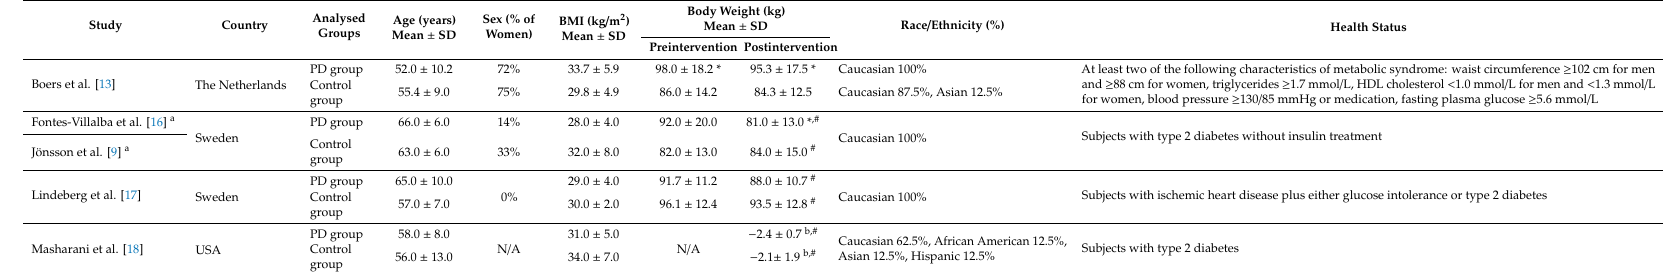
Table 2. Characteristics of the included studies and the study populations.